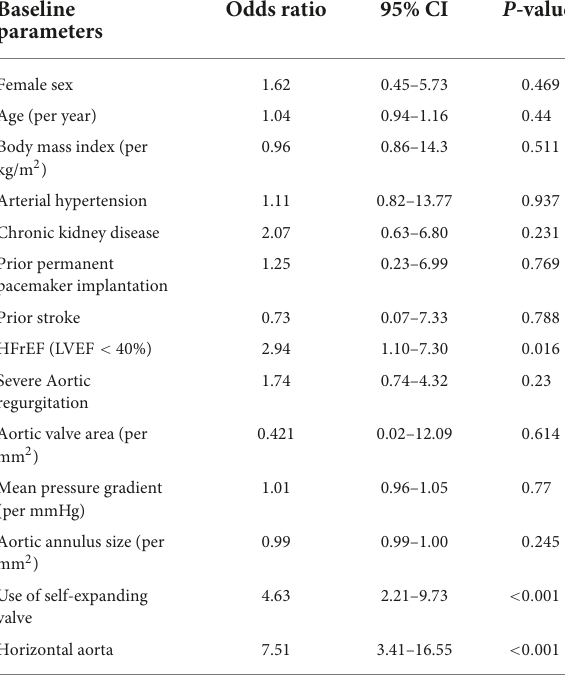
TABLE 4 Regression analysis of risk factors for transcatheter valve embolization and